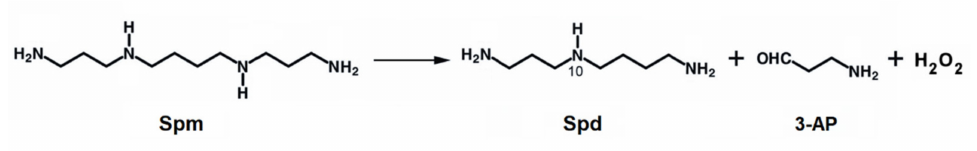
Figure 2. Spermine oxidase chemical reaction. Spermine (Spm) is oxidized to produce spermidine (Spd), 3-aminopropanal (3-AP) and hydrogen peroxide (H 2 O 2